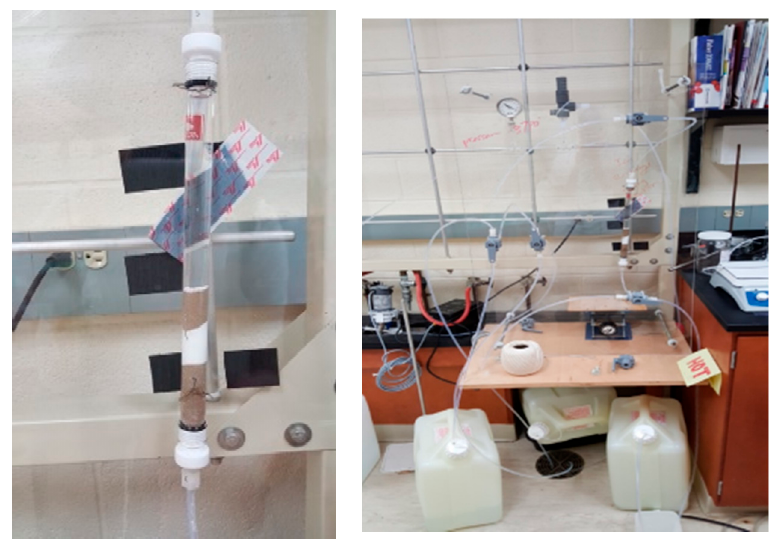
Figure 2. Full pressure apparatus shown on the right. Left image shows a packed column using sand and ion exchange resin.